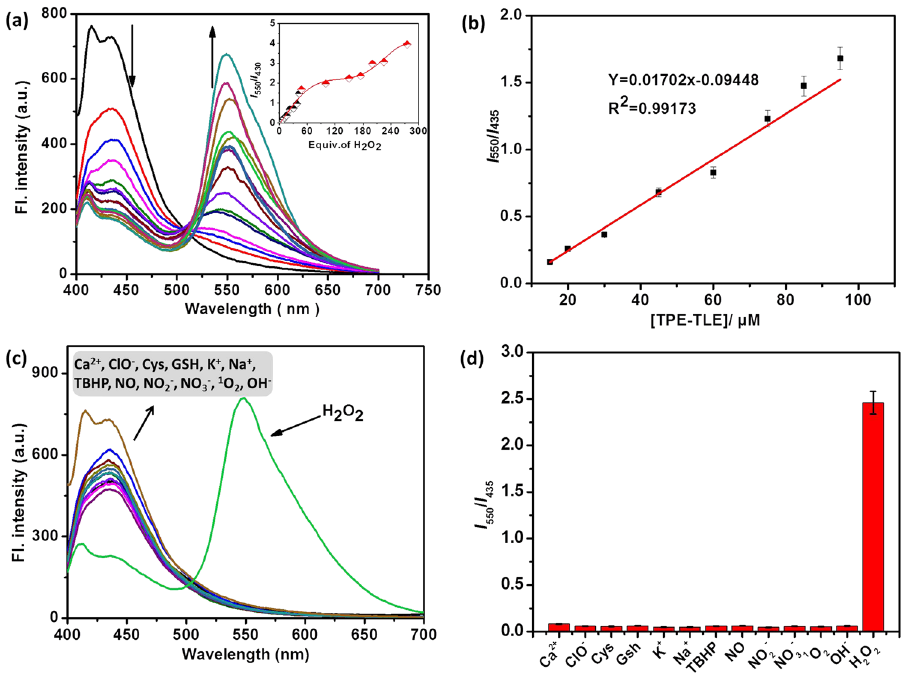
Figure 6. ( a) Fluorescence spectra of TPE-TLE (5.0 μ M) in pH 7.4 PBS buffer solution (containing 50% DMF) with the addition of H 2 O 2 (0–200 equiv.) Inset: the fluorescence intensity changes at I 550 / I 435 of TPE-TLE with the amount of H 2 O 2 . ( b ) Normalized response of the fluorescence signal by changing the concentration of H 2 O 2. λ ex = 380 nm. ( c ) Fluorescence spectra of TPE-TLE (5 μ M) in the presence of various relevant analytes. ( d ) Fluorescence responses of TPE-TLE (5 μ M) at 550 nm in the presence of various relevant analytes. The concentrations of the representative analytes are: amino acids, 1 mM; GSH, 2 mM; cations and anions, 3 mM; reactive oxygen and nitrogen species, 0.2 mM. The error bars represent standard deviation ( ±